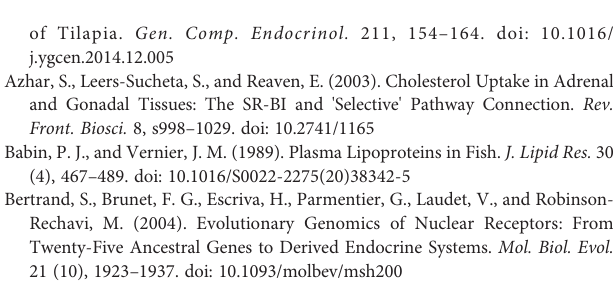
Supplementary Figure 1 | Immunoblotting of SIRT1 in Indian medaka ( O. melastigma ) livers detected with a polyclonal antibody (Proteintech-13161-1-AP). (A) One immunoreactive band with a molecular mass of about 116 kDa was detected. (B) The negative control did not indicate an immunoreactive band with the secondary antibody. The arrow indicated the immunoreactive band. M, marker; N, nuclear fraction. Supplementary Figure 2 | Immunoblotting of LXR a in Indian medaka ( O. melastigma ) livers detected with a monoclonal antibody (Santa Cruz sc-377260). (A) One immunoreactive band with a molecular mass of about 52 kDa was detected. (B) Thenegativecontroldidnotindicateanimmunoreactivebandwiththe secondary antibody. The arrow indicated the immunoreactive band. M, marker; N, nuclear fraction. Supplementary Figure 3 | Immunoblotting of SREBP-1 in Indian medaka ( O. melastigma ) livers detected with a monoclonal antibody (Santa Cruz sc-13551). (A) The majorimmunoreactivebandhadamolecularmassofabout85kDa. (B) Negativecontrol did not indicate an immunoreactive band with the secondary antibody. The arrow indicated the immunoreactive band. M, marker; N, nuclear